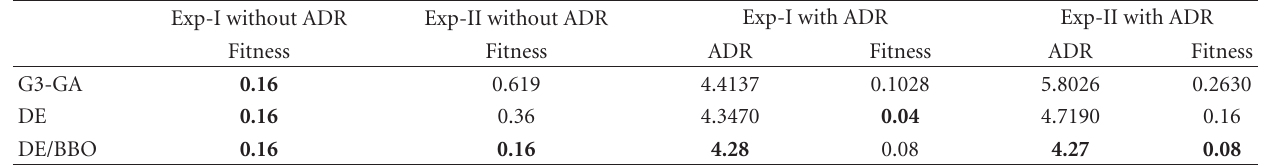
Table 5: Comparison of G3-GA with